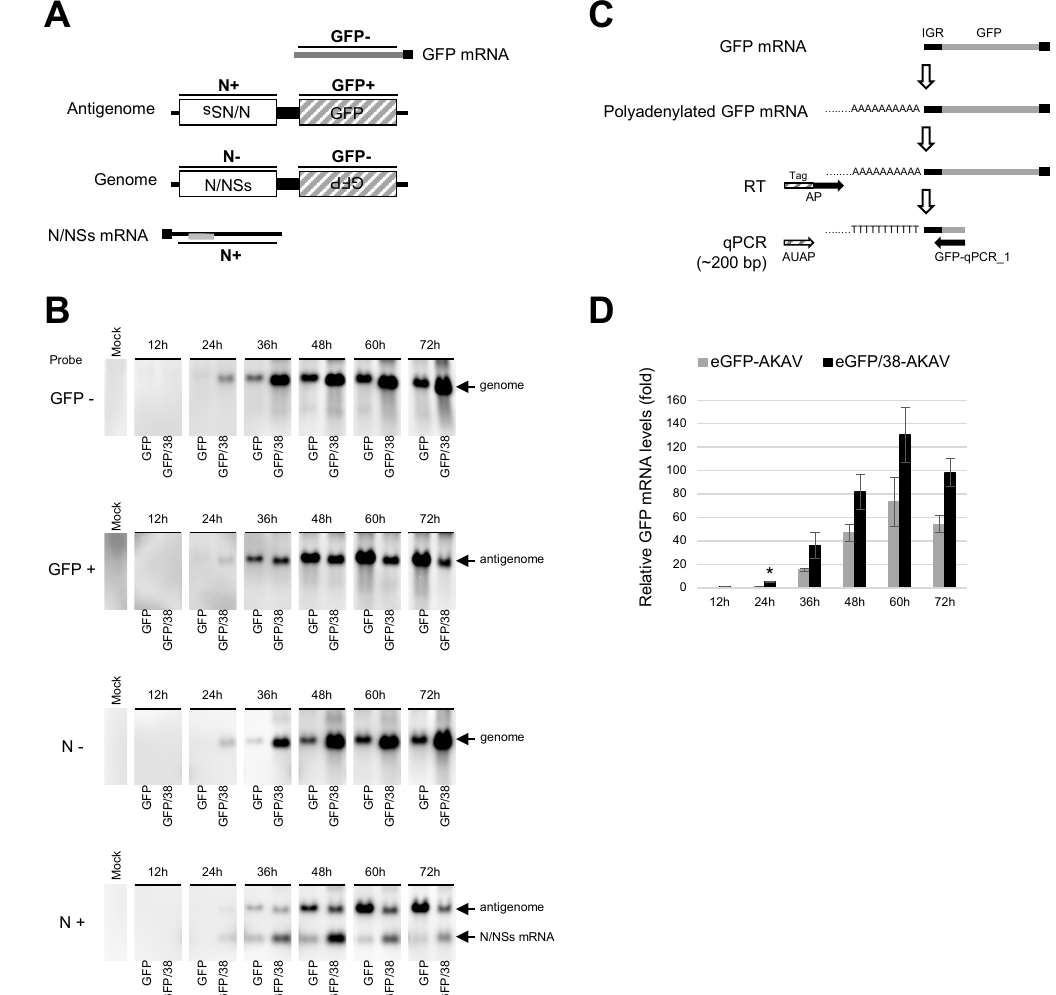
Figure 4. Analysis of virus-related RNAs in cells infected with recombinant viruses. ( A ) Schematic diagram of RNA probes used is shown as N (-), N ( + ), GFP (-), and GFP ( + ). ( B ) HmLu-1 cells were infected with either eGFP-AKAV (GFP) or eGFP / 38-AKAV (GFP / 38) at a MOI of 0.1. Total RNAs were extracted from the infected cells at 12 h intervals. Bands corresponding to genome RNA, antigenome RNA, and N / NSs mRNA were indicated by northern blot analysis using specific probes. ( C ) A qRT-PCR strategy was used to quantify GFP mRNA. Polyadenylated GFP mRNA was reverse-transcribed using AP primer (oligo dT primers containing tag sequence). The RT product was subjected to qPCR using AUAP primer (binding to the tag sequence) and GFP-qPCR_1 primer (binding to eGFP). ( D ) The qRT-PCR results are normalized to the level of eGFP mRNA extracted from cells infected with eGFP-AKAV at 24 hpi. The result with eGFP-AKAV at 12 hpi was excluded due to a distinct peak of melt curve. The results are presented as the mean ± SD (error bars) from three independent experiments. * p < 0.05; Mann–Whitney U